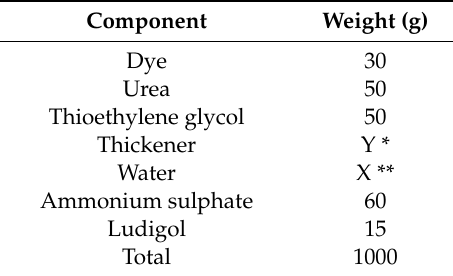
Table 1. Printing paste for acid dyestu ff